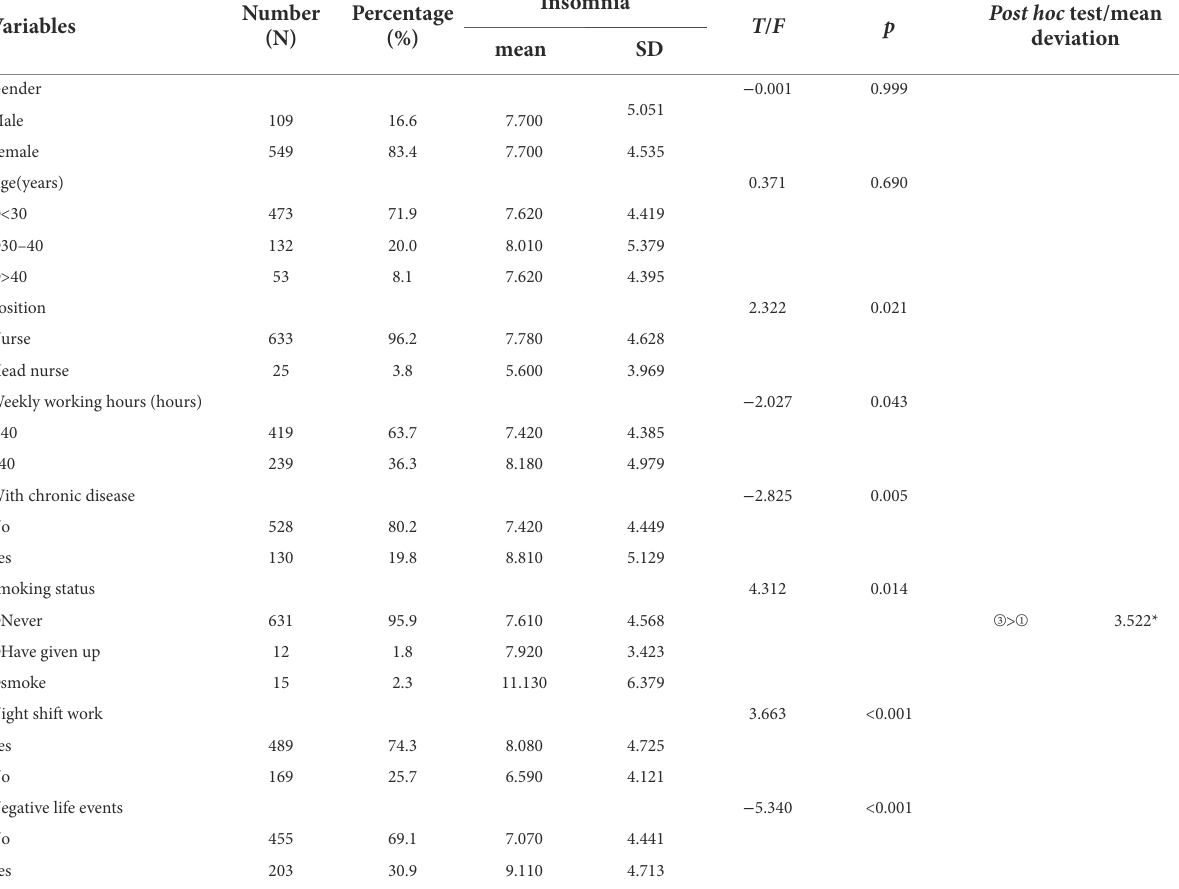
TABLE 1 Demographic statistics and the influence of demographic information and life behavior factors on